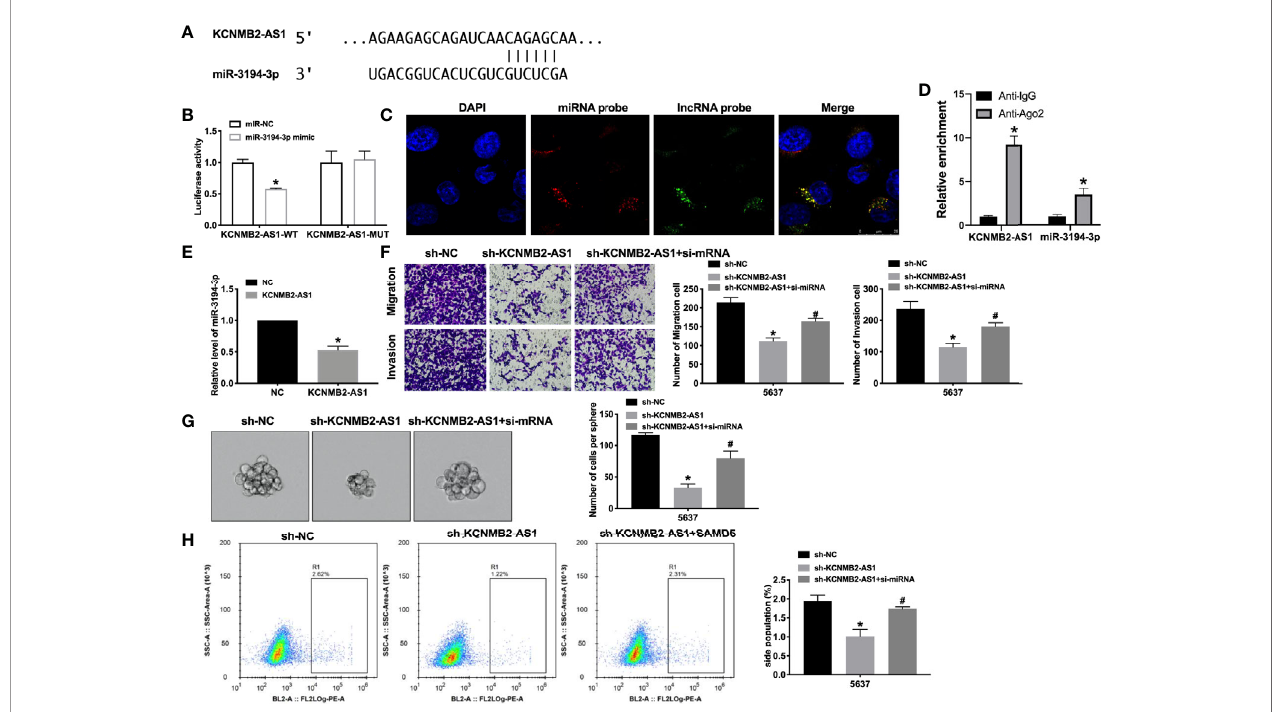
FIGURE 4 | KCNMB2-AS1 sponges to miR-3194-3p. (A) miRNA binding sites prediction of lncRNAs in Starbase 3.0. (B) The activity of luciferase was measured. n = 3. (C) Co-localization of miR-3194-3p and KCNMB2-AS1 by FISH. (D) The enrichment analyze by AGO2 RIP assay. (E) The expression level of miR-3194-3p was detected. n = 8. (F) Detecting cell migration and invasion by Transwell invasion assay. n = 5. (G) Tumor sphere-forming ability was assessed. n = 5. (H) The side population of bladder cells was determined by fl ow cytometry. n = 5. * P < 0.05, # P <